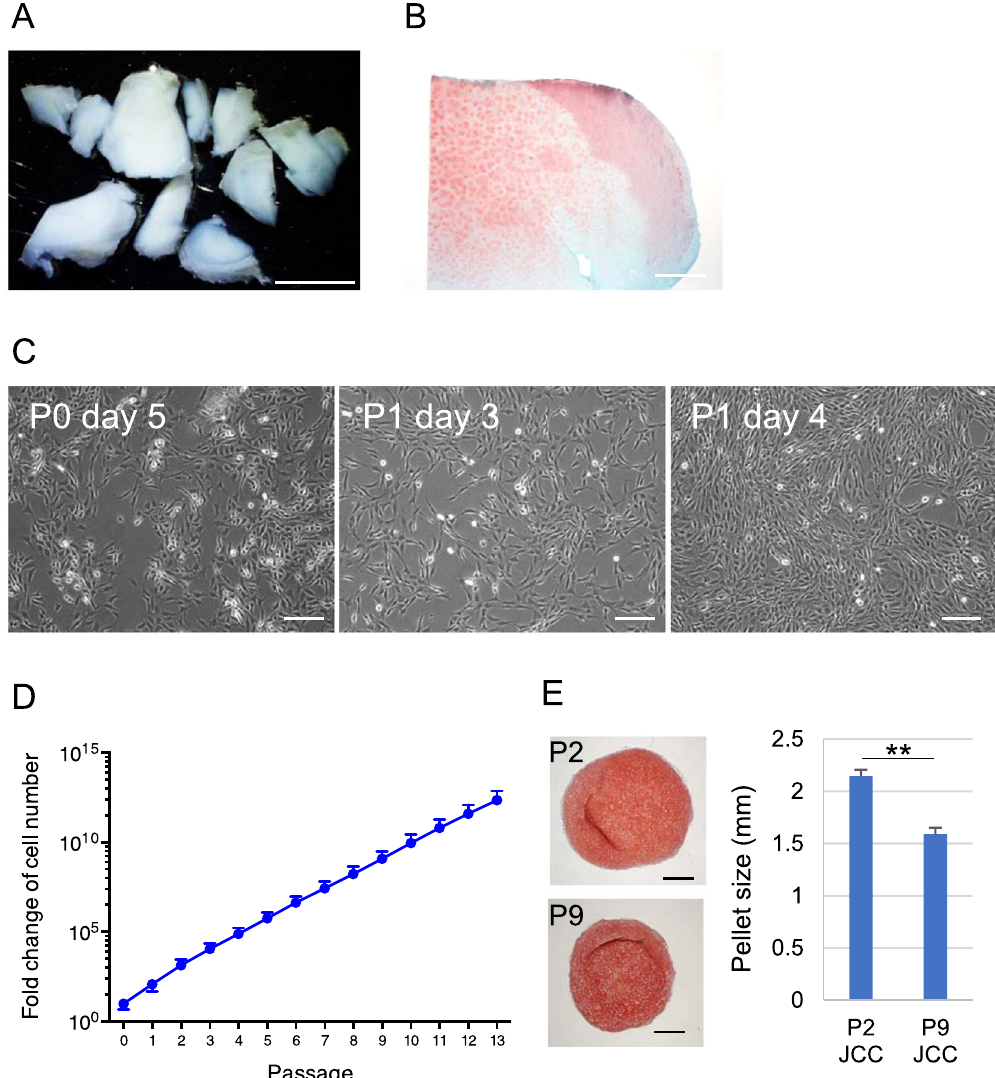
Fig. 1 Isolation of chondrocytes from juvenile cartilage surgical discards and in vitro expansion of juvenile chondrocytes. A Juvenile donor-derived cartilage tissues under stereomicroscope. Scale bar: 5 mm. B Safranin-O staining of cartilage tissue. Scale bar: 500 μ m. C Phase- contrast images of cultured chondrocytes. Scale bars: 200 μ m. D Average fold-change of in vitro cell expansion. Data shown as mean and SD ( n = 13 individual donors). E In vitro differentiated JCC pellets. Photos show Safranin-O staining of P2 JCCs (top) and P9 JCCs (bottom). Bars: 500 µm. Right graph shows pellet size diameter measurements ( n = 2). Error bars indicate SD. ** p < 0.01 by Student ’ s t